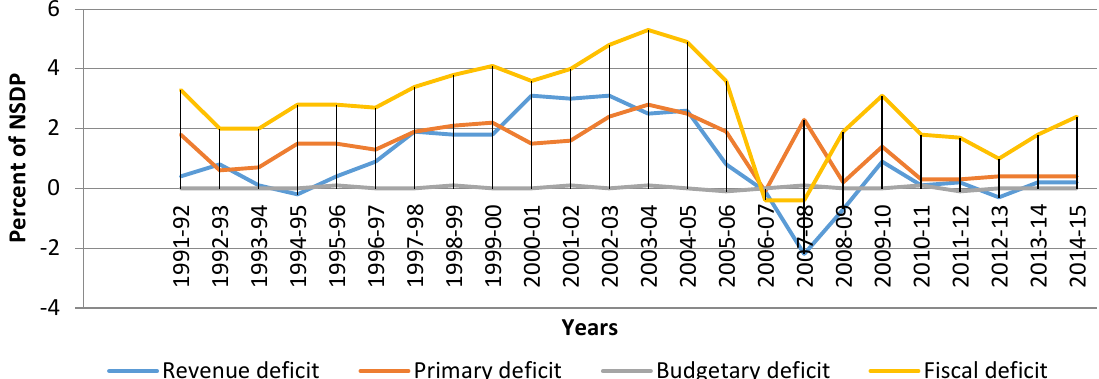
Source: RBI handbook of statistics for various